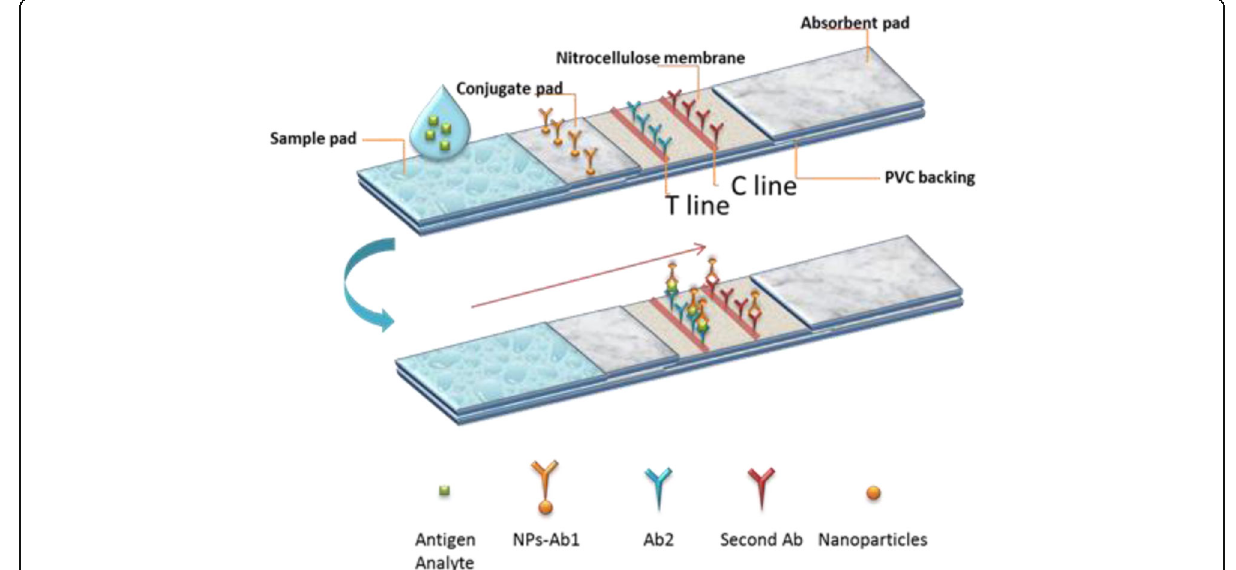
Fig. 1 The schematic image of the configuration and the principle of the